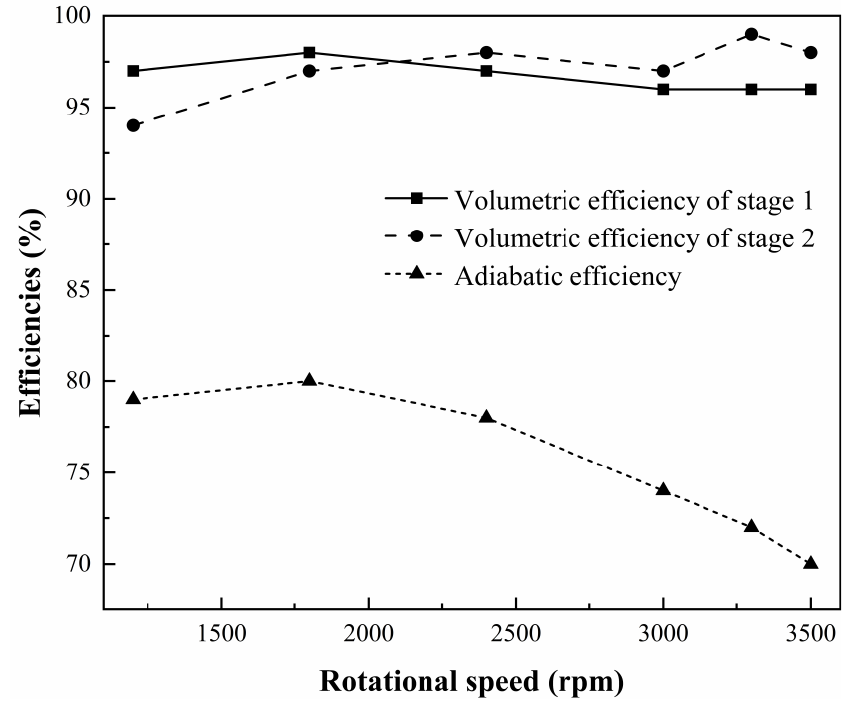
Figure 13. Effect of rotational speed on volumetric efficiency and adiabatic